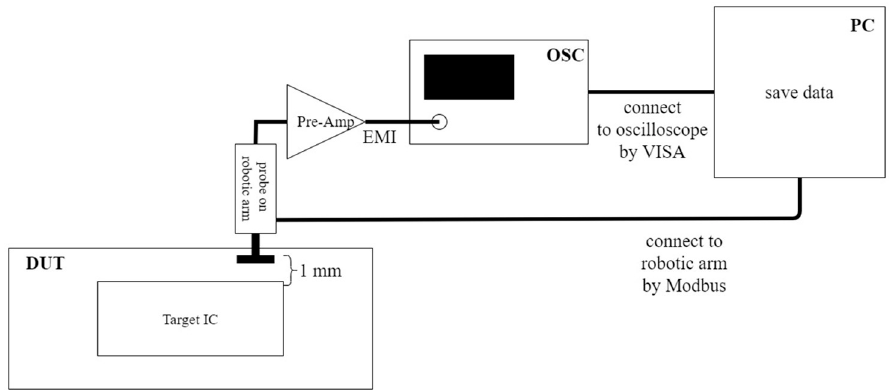
Figure 7. The schematic of the proposed measurement platform.